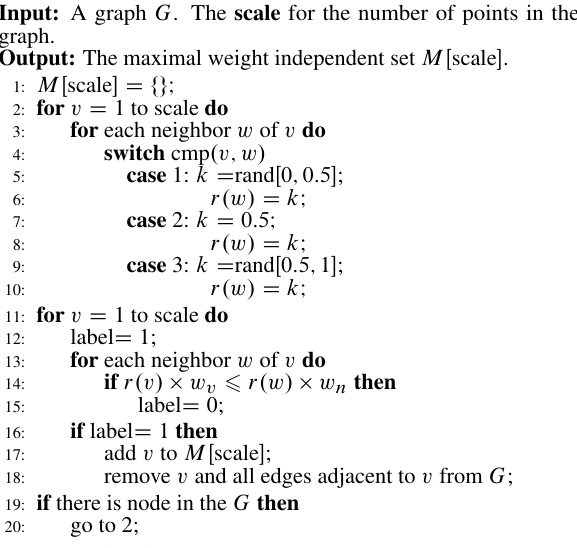
Algorithm description. The pseudo code is shown in Algorithm 4. The algorithm runs multiple rounds,